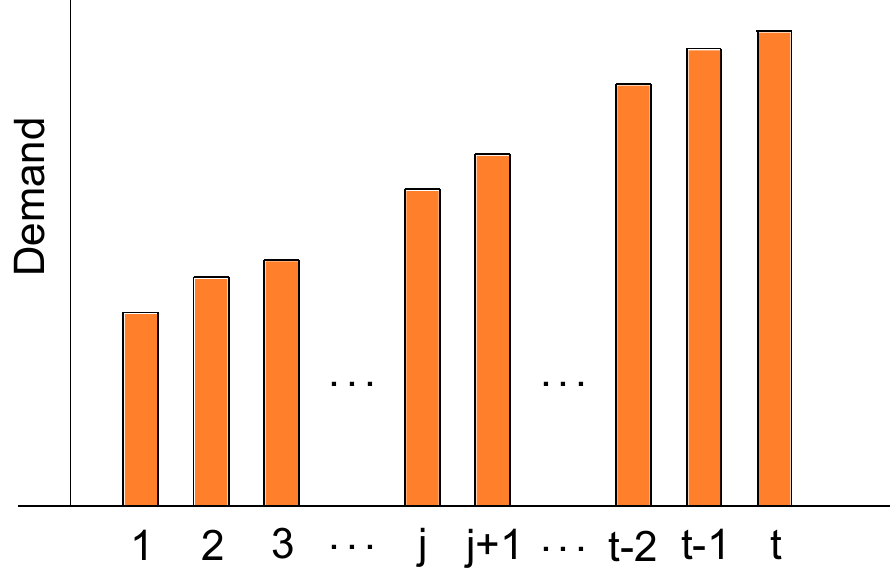
Figure 2. Sorting demands in a contract of duration t